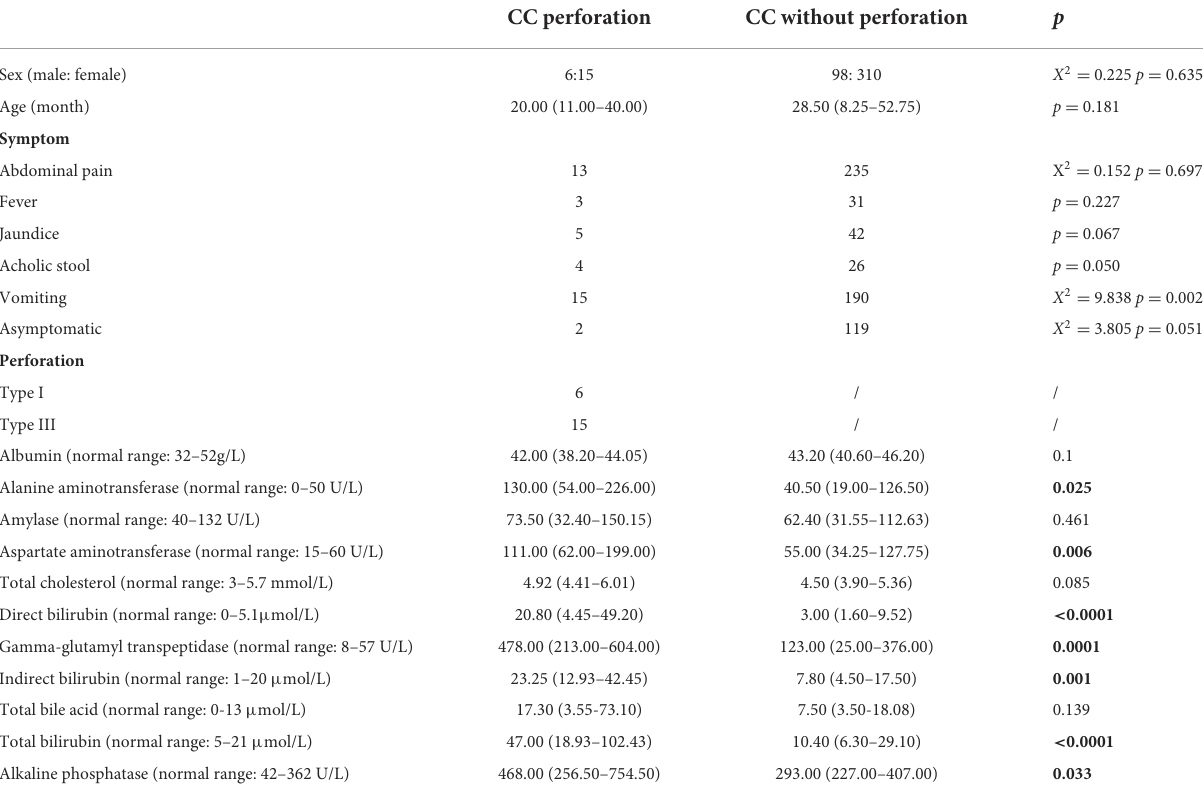
TABLE 2 Demographic and laboratory data of CC patients with or without perforation. CC perforation CC without